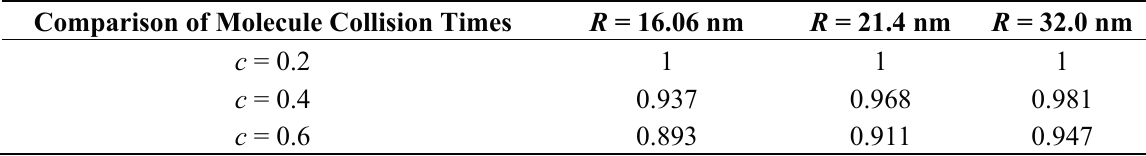
Table 3. Comparison of molecule collision times in the zone which suffers no direct effects from the wall between different gas-solid interaction strength.